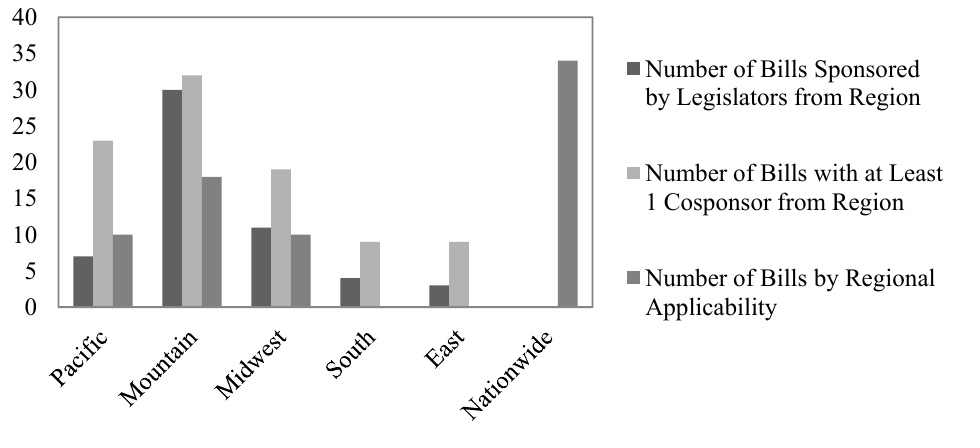
Figure 2. Bill sponsorship, co-sponsorship, and applicability by region. (Pacific = CA, OR, W, AK, HI; mountain states = MT, ID, NV, WY, UT, CO, AZ, NM; Midwest = ND,